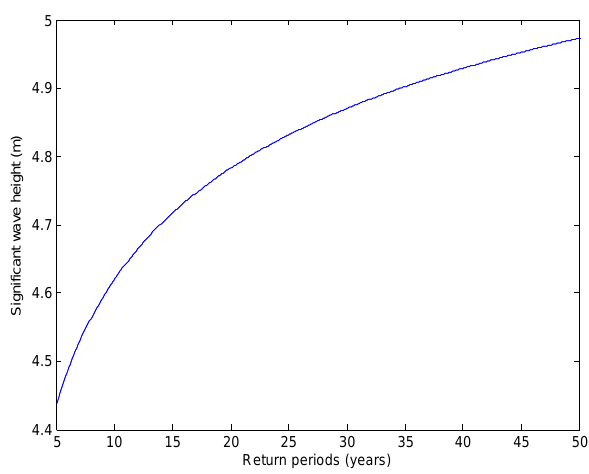
Figure 6. Predicted significant wave height for different return periods.